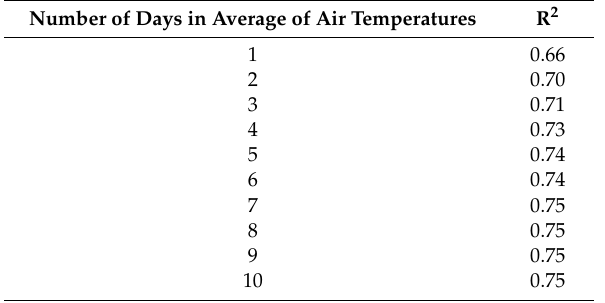
Table 3. Results of a stepwise forward multiple regression for the United States lakes. The variables are listed in the order of their selection for the model and for each variable we have listed the probability that it is statistically significant, the coefficient of determination (R 2 ), the root-mean-squared-error (RMSE) and the Akaike information criterion (AIC).